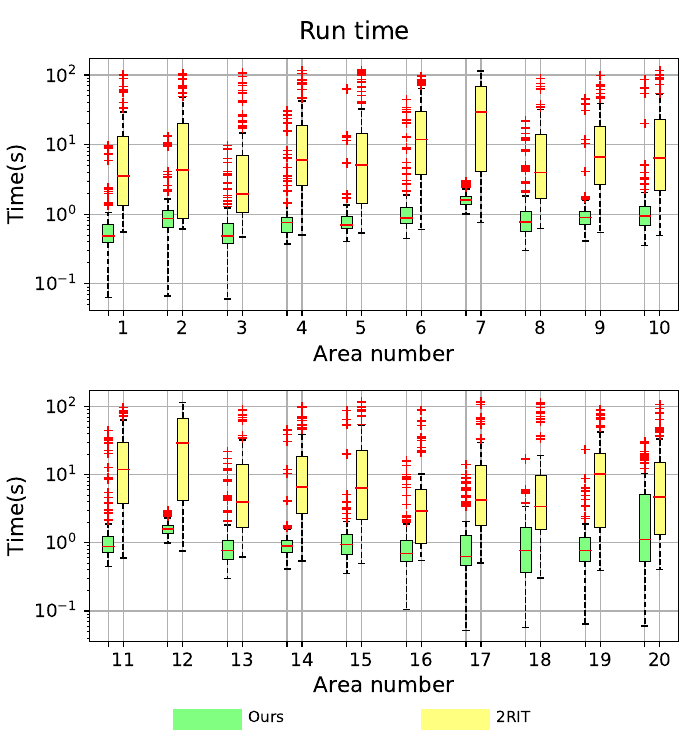
Figure 11. Run time of geolocalization on the “multi-areas data set”. Here, run time refers to the time usage in the querying stage, which includes the time for PICF detection and descriptor computing, the time for PICF matching, and the time for estimating, refining, and validating the